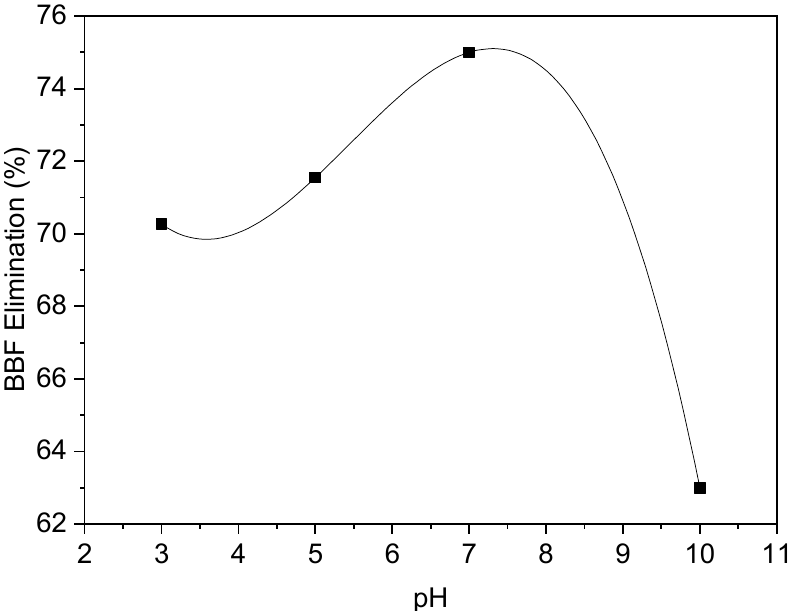
Figure 5. Evaluation of the effect of pH on dye removal in industrial discharge: ∆ P = 4 bar; [BBF] = 40 mg/L; [COD] doped wastewater = 220 mg O 2 /L; Turbidity doped wastewater = 28 FNU; and treatment time = 15 min.